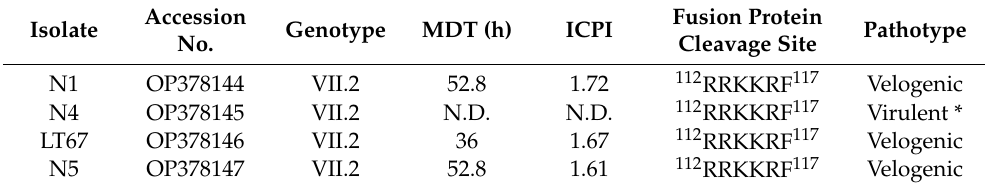
Table 3. Genotypic and pathotypic indices of NDV isolates analyzed in this study.